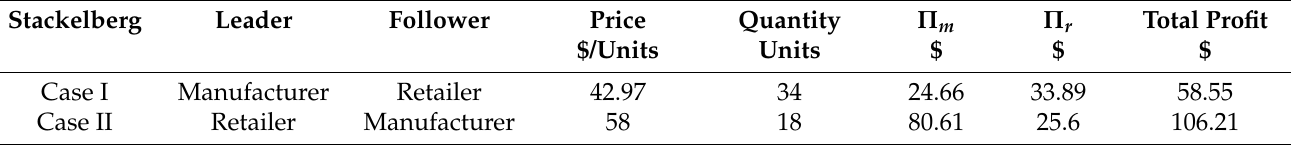
Table 4. Decentralized (Stackelberg) supply chain numerical